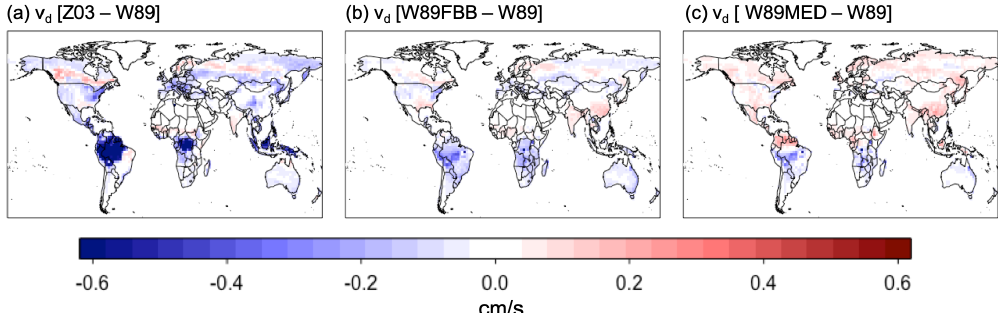
Figure 10. Differences in average daytime v d between different dry deposition schemes for 2010–2014